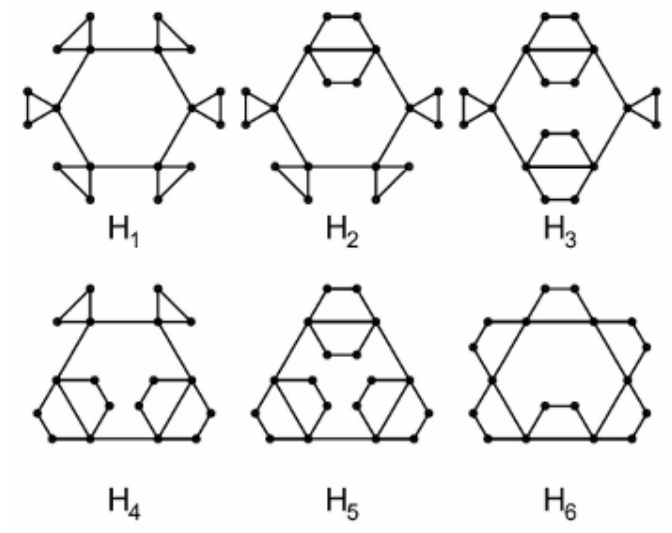
Figure 5: Non-isomorphic harmonic graph having spectral radius